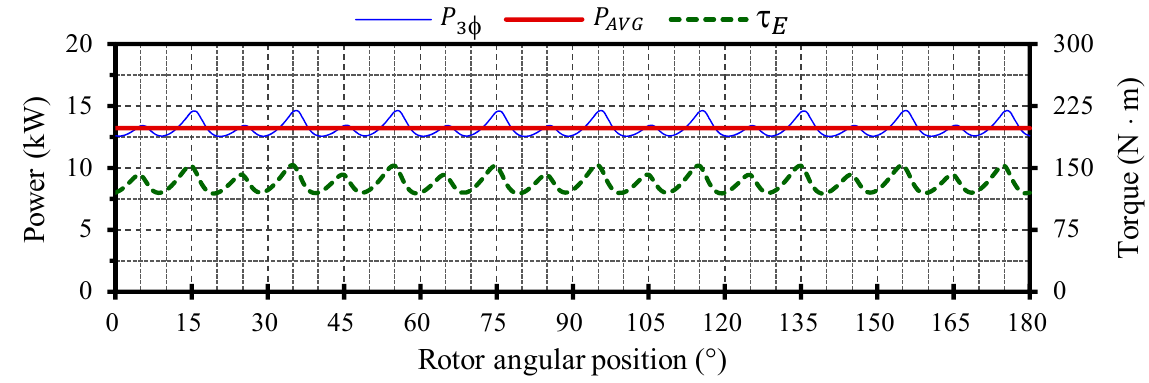
Figure 15. Output power and electromagnetic torque under full-load operation.